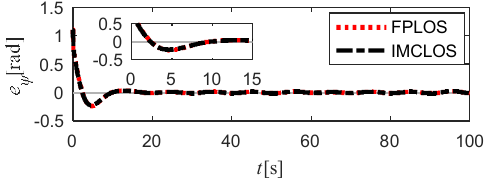
Figure 4. Heading tracking error e ψ.